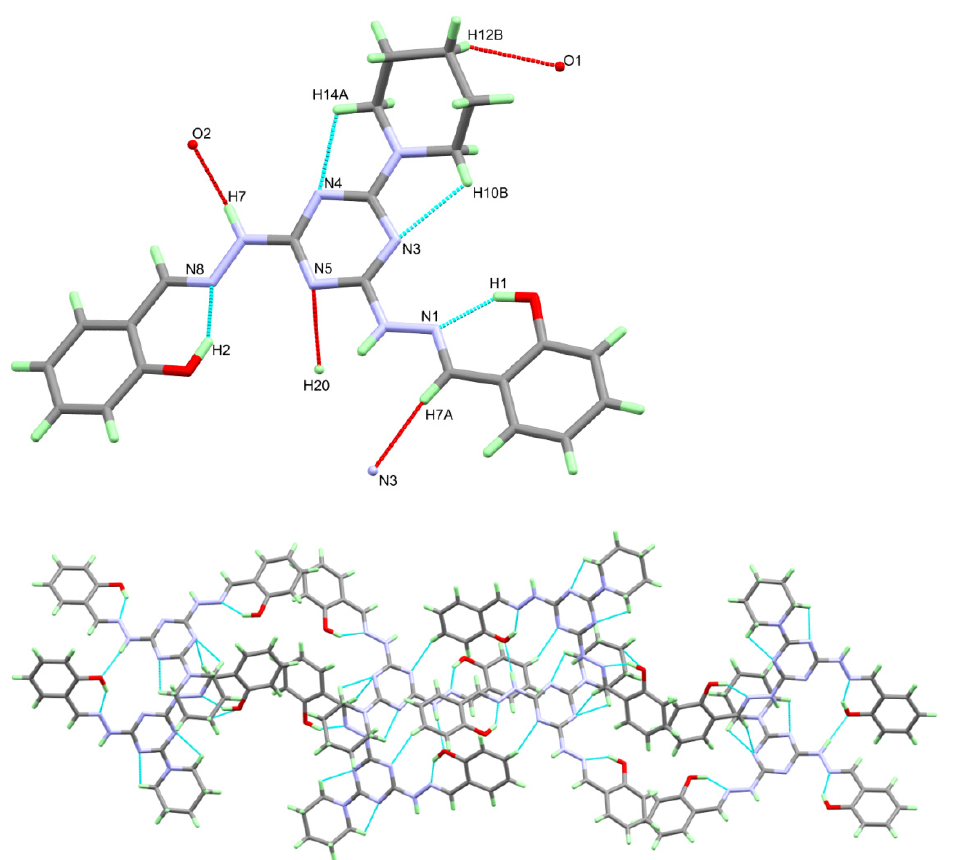
Figure 4. Hydrogen bond contacts ( upper ) and molecular packing ( lower ) of 4 . The supramolecular structure of 4 is controlled by strong N7-H7...O2 hydrogen bond- ing interaction with a hydrogen-acceptor distance of 1.996(2) Å and donor-acceptor distance of 2.918(1) Å. In addition, the molecules are further connected by weak C-H...O interactions (Table 3). Presentation of the molecular packing is given in Figure 4 (lower